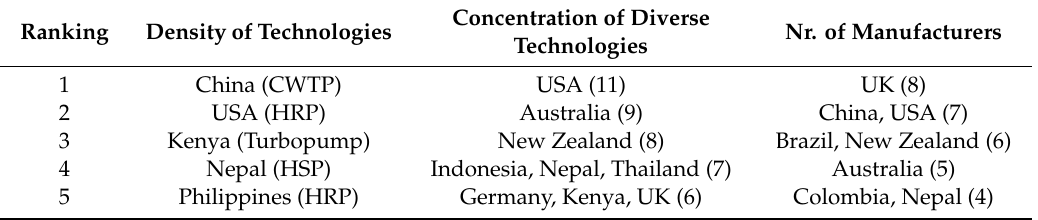
Thetop-fiverankingofcountriesareorderedfromhighest(1)tolowest(5). Thedensityoftechnologies, concentration of diverse technologies, and number of manufacturers, are expressed regarding the predominant technology, number of distinct technologies, and number of distinct manufacturers,